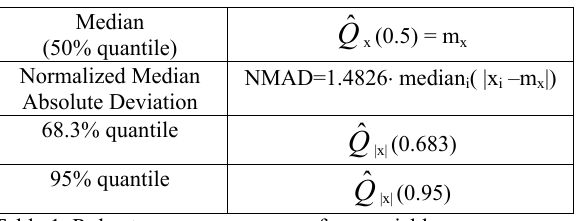
and then treated as absolute errors.